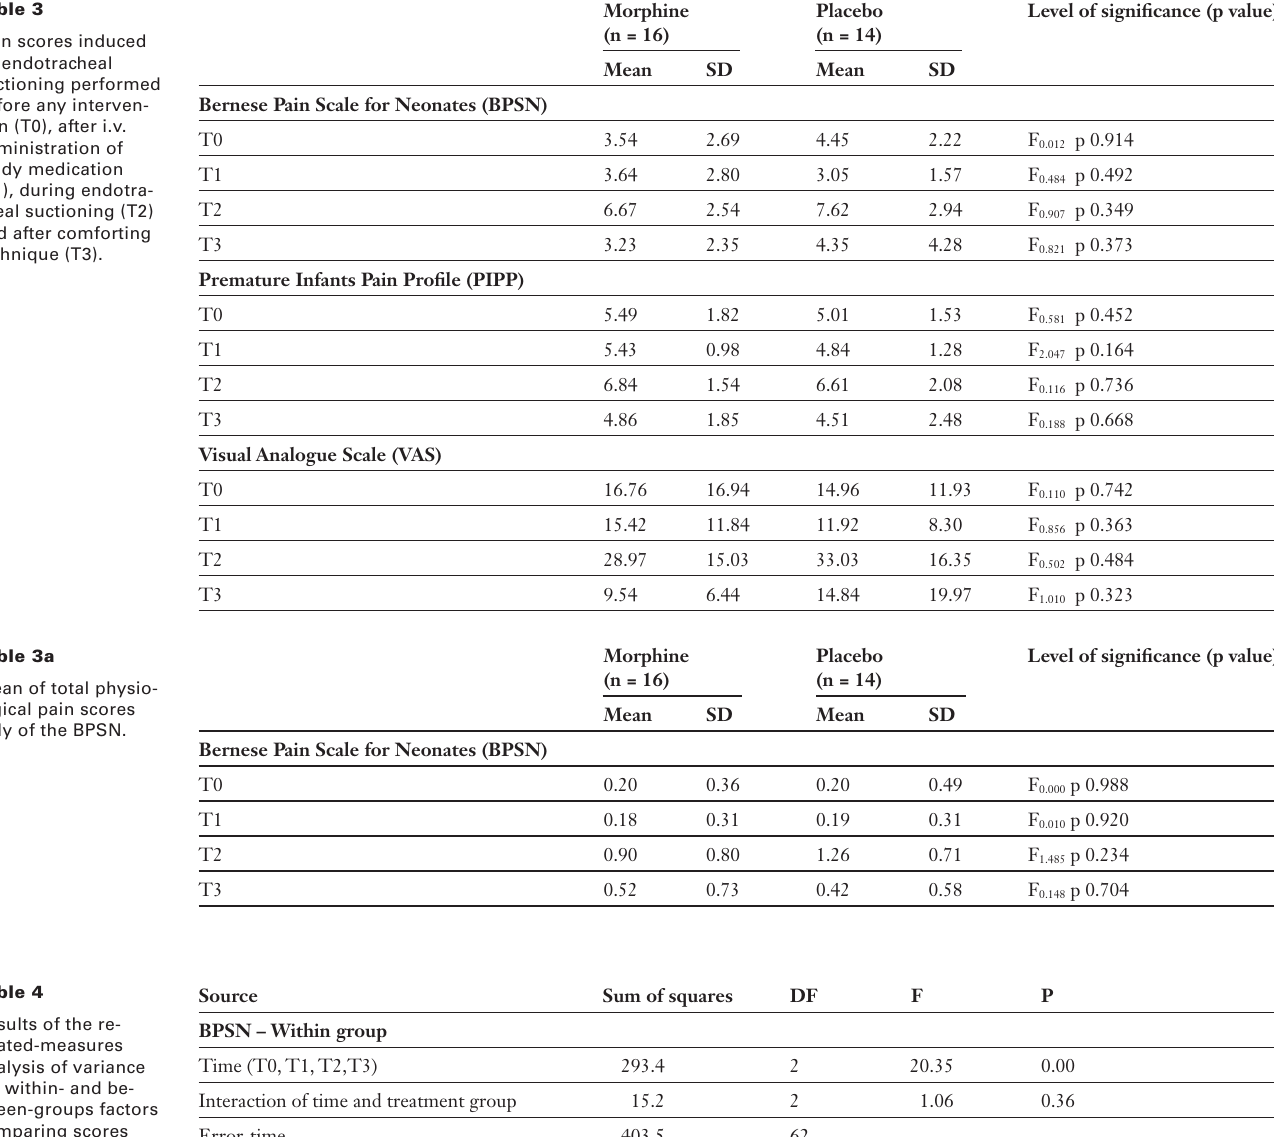
Results of the re- peated-measures analysis of variance for within- and be- tween-groups factors comparing scores during ETS (T0–T3).